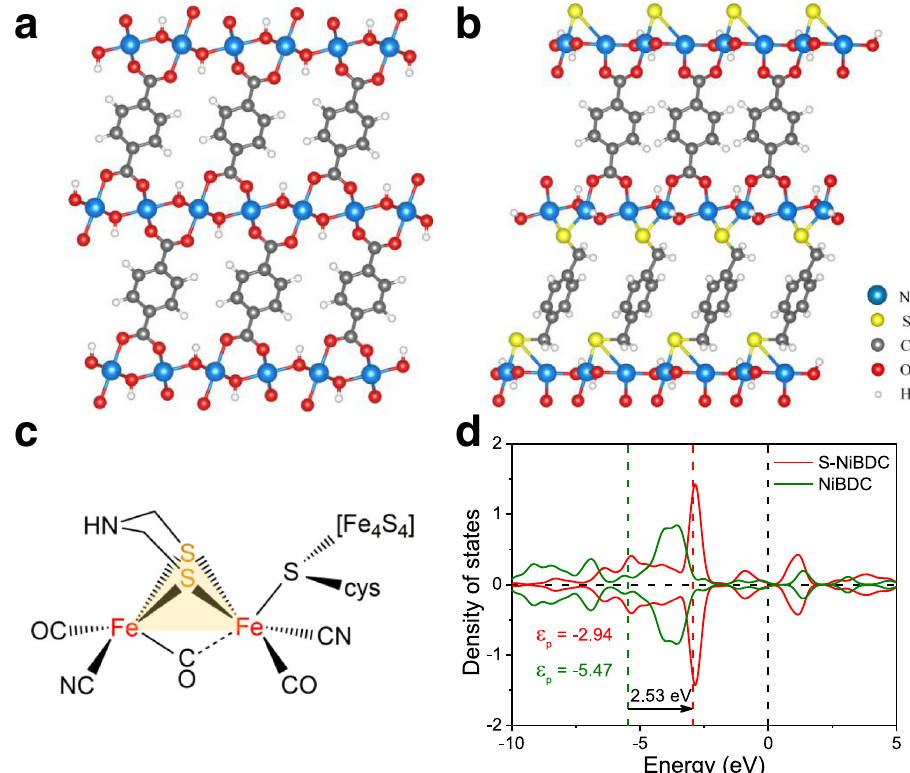
Fig. 1 | The effect of ligand modulation for density of states by theory predic- tions. Models of optimized NiBDC ( a ) and S-NiBDC ( b ) structures. c Structure of